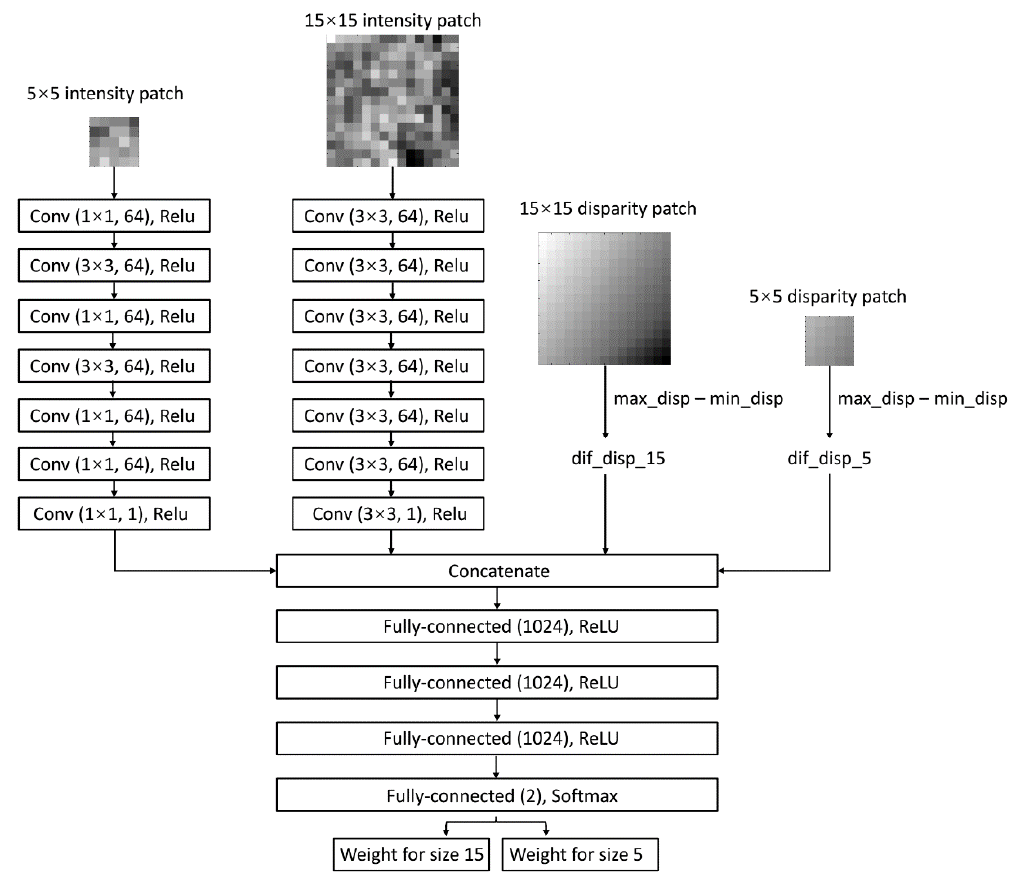
Figure 3. Proposed Adaptive Matching Fusion based on Convolutional Neural Network (AMF-CNN) structure.